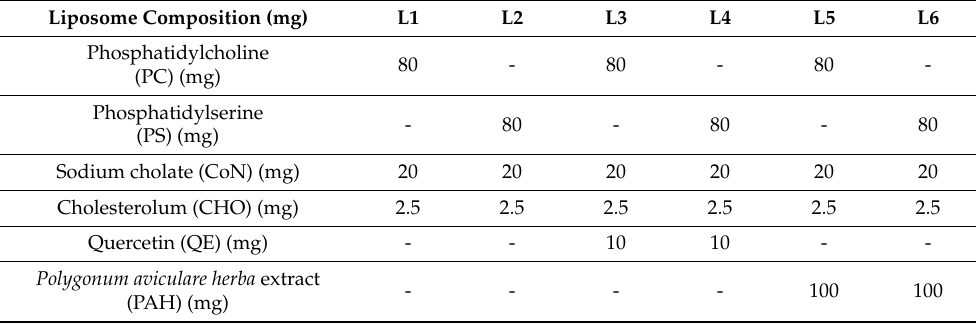
Table 1. The composition of the liposome